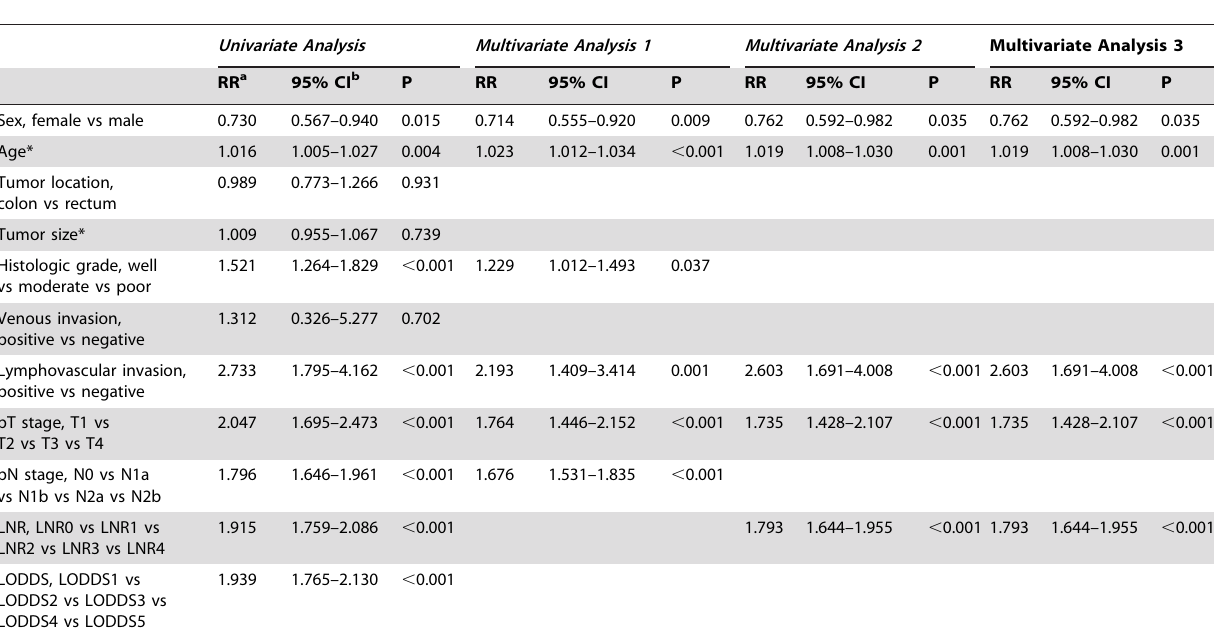
Table 2. Univariate and Three-step Multivariate Analysis (Cox Proportional Hazard Model) of Prognostic